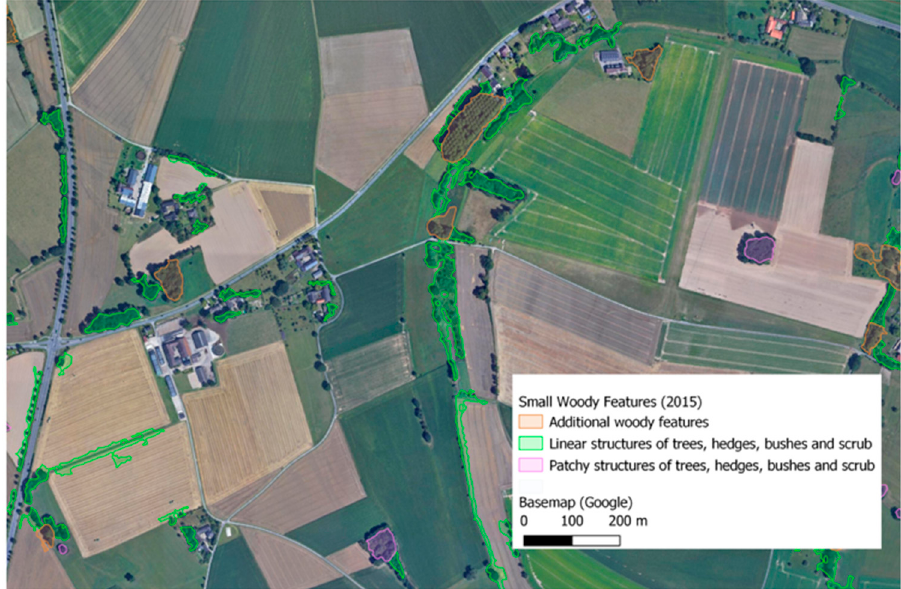
Figure 1. Three classes of small woody landscape features, i.e., linear, patchy, and additional, embedded within agricultural landscapes.